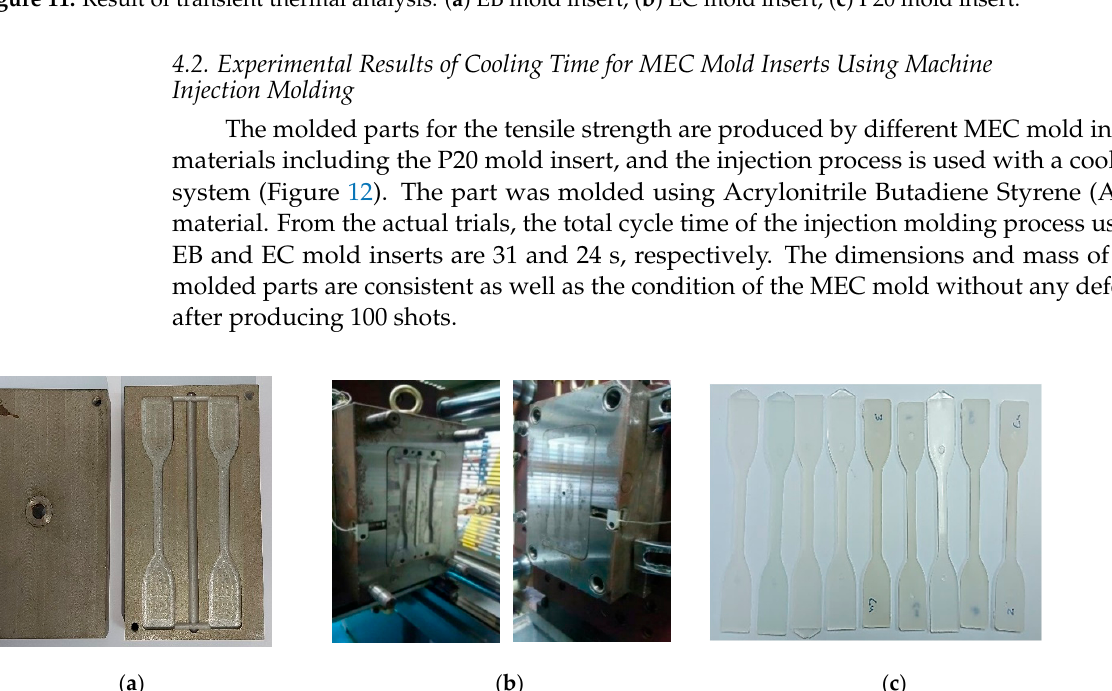
Figure 11. Result of transient thermal analysis: ( a ) EB mold insert; ( b ) EC mold insert; ( c ) P20 mold insert. Table 9. Result of cooling time.